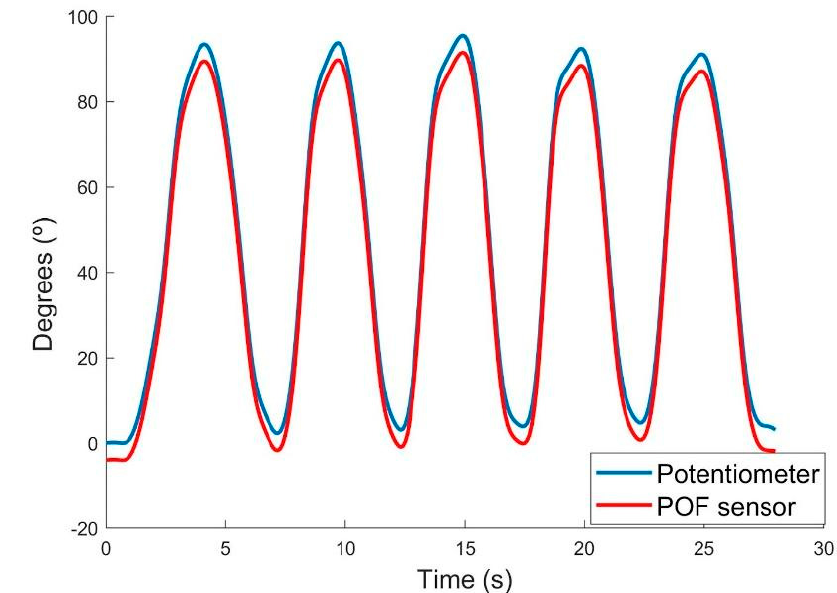
Figure 6. Results of the joint angle measurement for one participant. The blue line represents the potentiometer response and the red one represents the POF sensor response, in degrees.